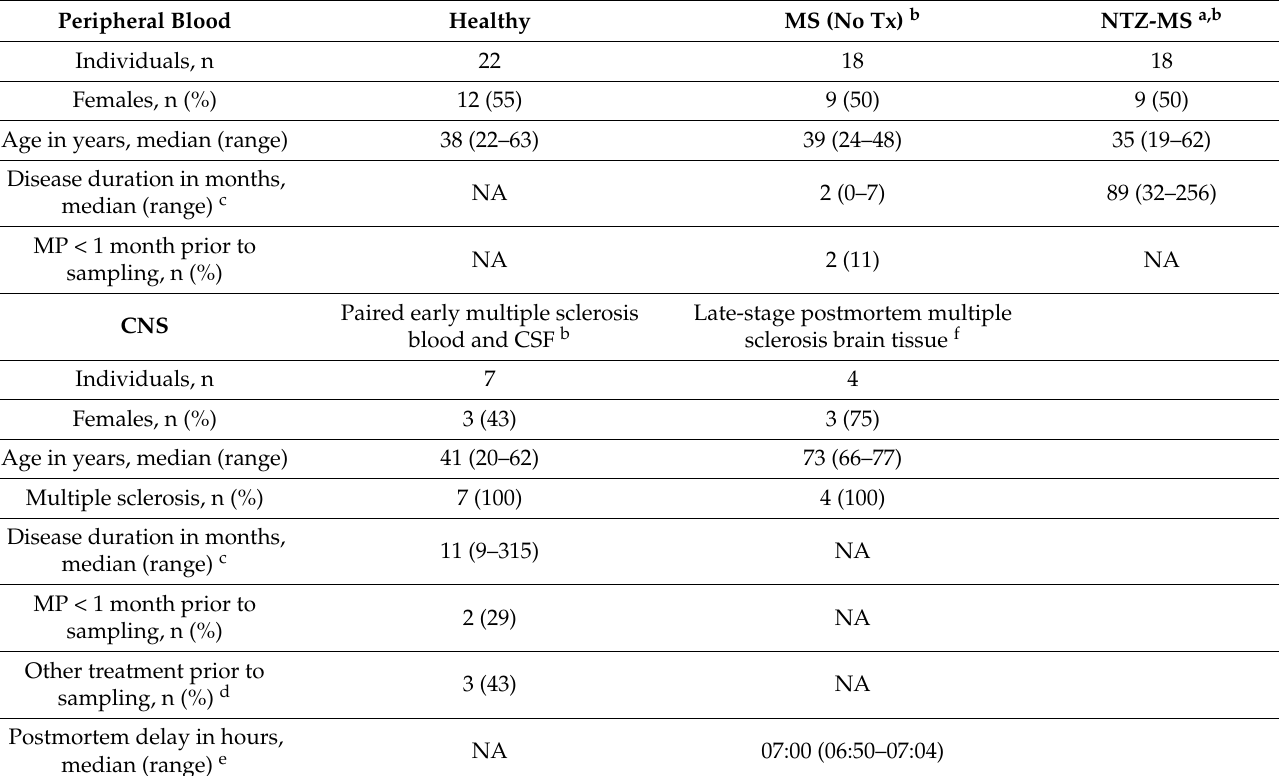
protocol mentioned above. Samples were measured using the LSRFortessa and/or sorted using the FACSAria III (both BD Biosciences). CD8 + memory (CD45RA − ) T cells were Table 1. Overview of cohort characteristics.